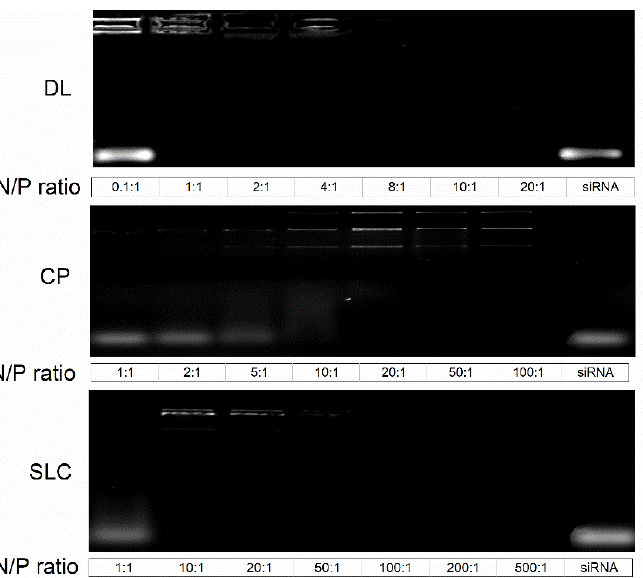
Figure 1. Analysis of siRNA loading efficiency in the respective N/P ratio for the respective nanocar- riers. The last lane represents uncomplexed siRNA.